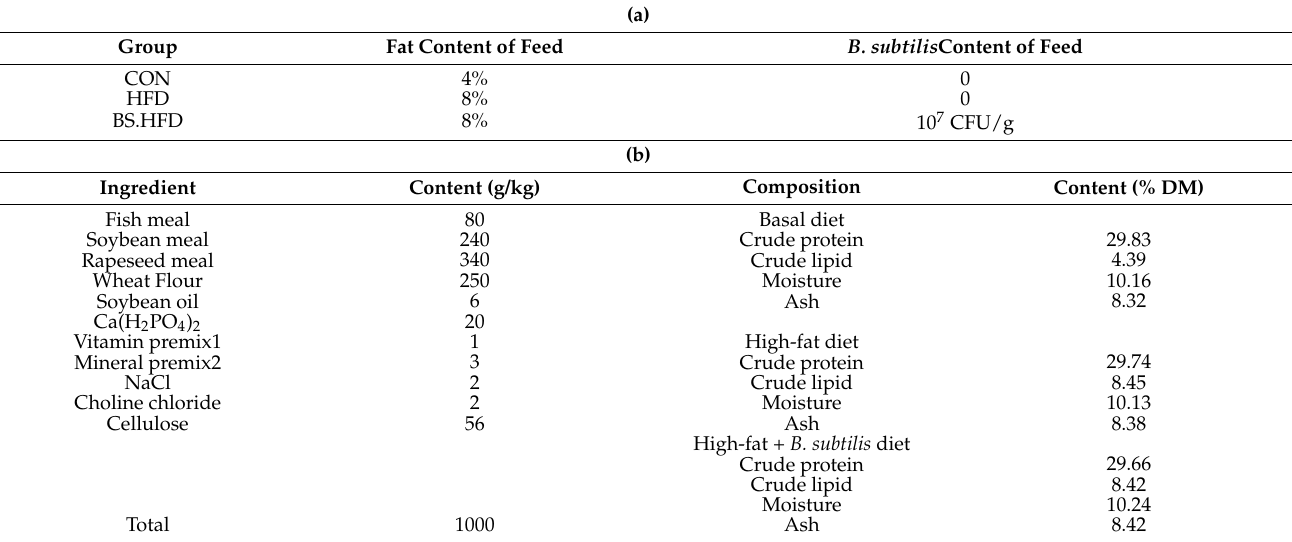
Table 1. ( a ) Design of the three experimental diets; ( b ) compositions of the experimental